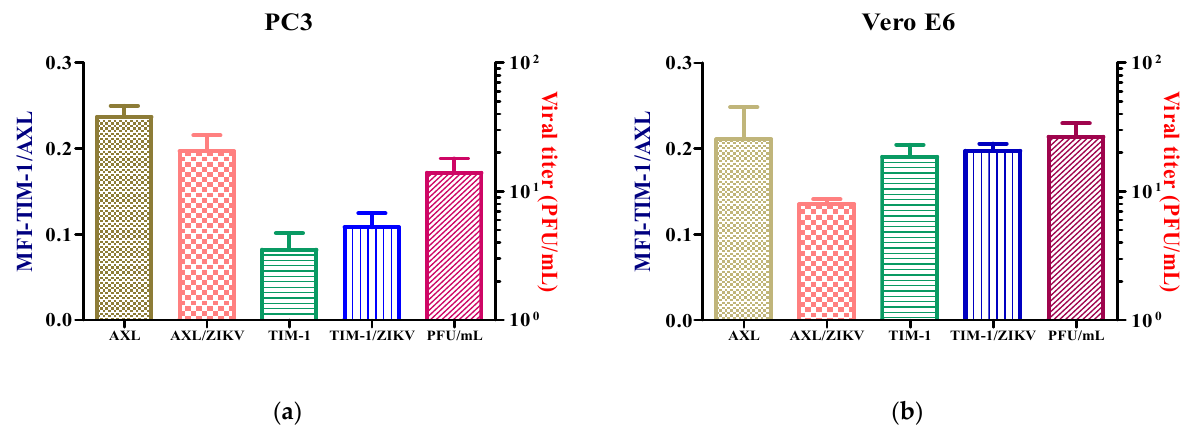
Figure 3 . Expression of AXL and TIM-1 receptors in PC3 ( a ) and Vero E6. ( b ) The infected and uninfected cells after 24 h were detected by flow cytometry. Analysis shows mean and SEM (Standard Error Medium) from independent experiments.